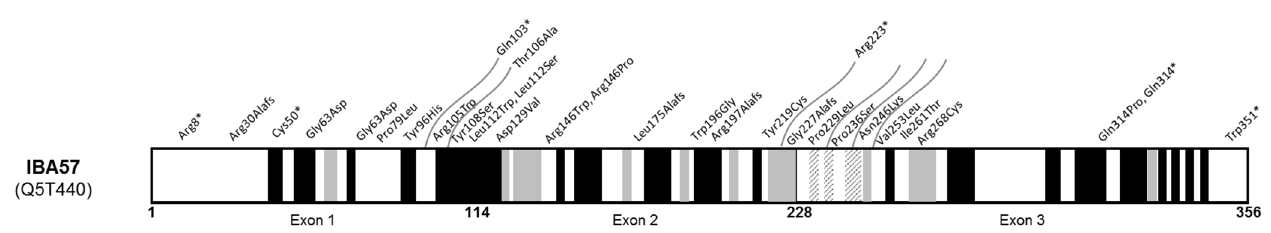
Figure 4. Schematic of IBA57 protein (NP_001010867) with reported variants. Schematic secondary structure shows α -helix (grey), β -strand (black), and turn (grey and white crosshatches) (adapted from UniprotKB, protein Q5T440).